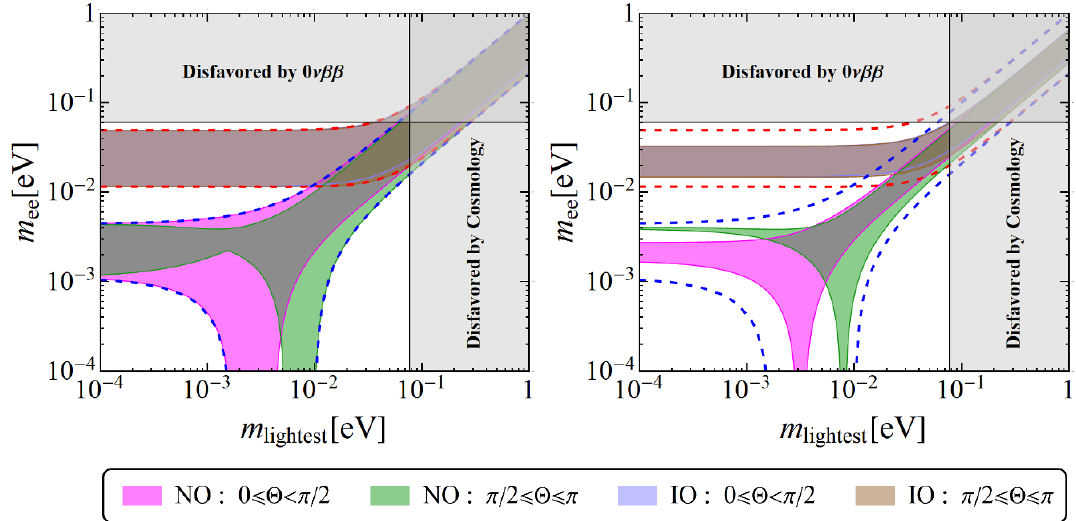
Figure 11 . Attainable values of the e(cid:11)ective Majorana mass m ee as a function of the lightest neutrino mass in the generalized e (cid:0) (cid:22) re(cid:13)ection scheme. In the left panel the CP label (cid:2) is varied over all its values, while we (cid:12)x (cid:2) = 2 (cid:25)= 5 and (cid:2) = 3 (cid:25)= 5 in the right panel. Notice that the expected m ee for 0 (cid:20) (cid:2) < (cid:25)= 2 and (cid:25)= 2 (cid:20) (cid:2) (cid:20) (cid:25) almost coincide in the case of IO. The red (blue) dashed lines delimit the most general allowed regions for IO (NO) neutrino mass spectrum obtained by varying the mixing parameters over their 3 (cid:27) ranges [3]. The present most stringent upper limits m ee < 0 : 061 eV from KamLAND-ZEN [49] and EXO-200 [50] is shown by horizontal grey band. The vertical grey band indicates the current sensitivity of cosmological data from the Planck collaboration